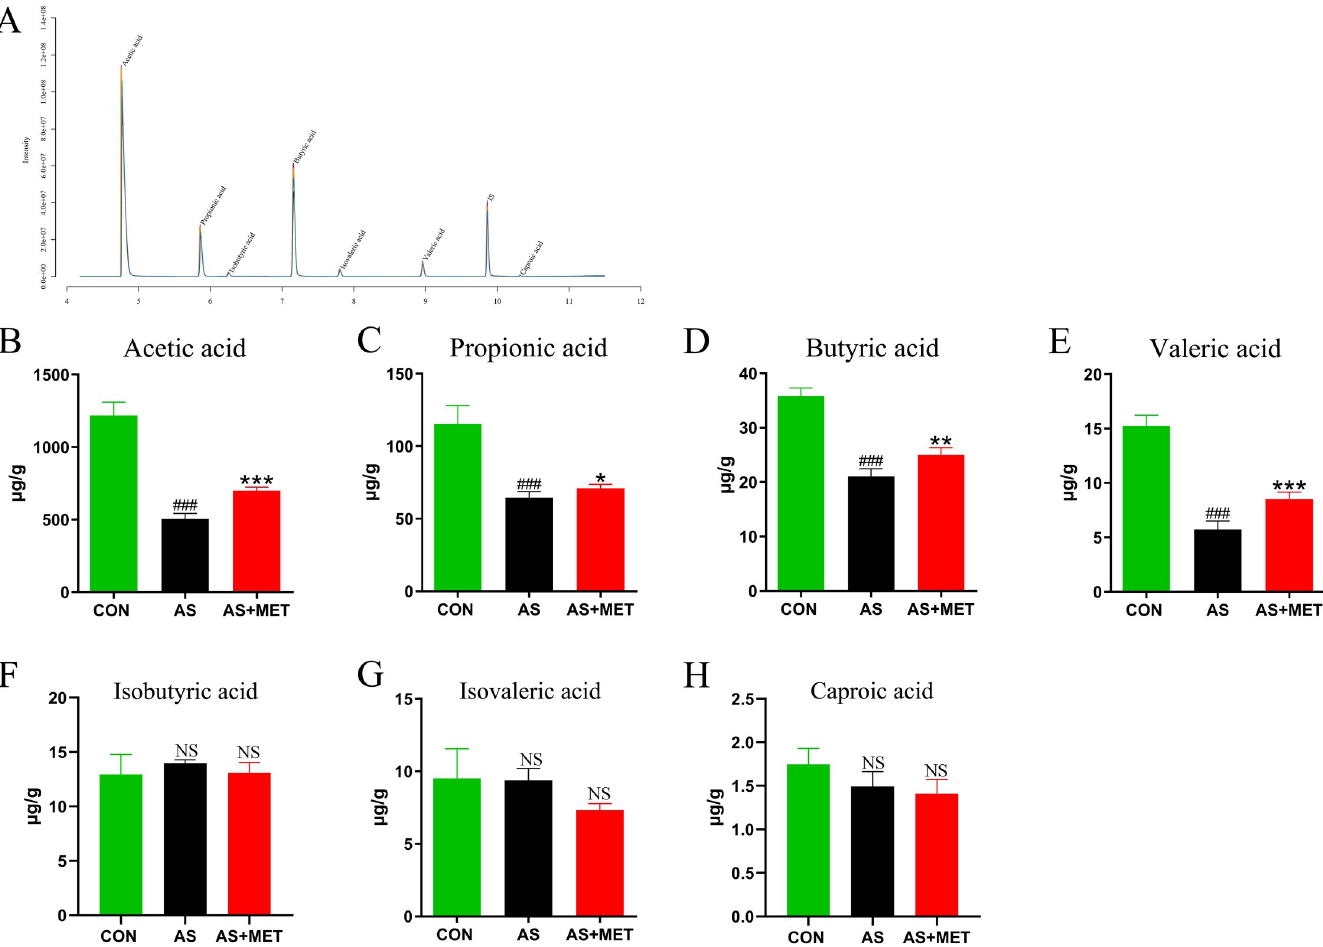
Fig 6. Measurement of the contents of SCFAs in different groups. Chromatogram of mice stool (A) . Determination of levels ( μ g/g) of Acetic acid ( B ); Propionic acid ( C ); Butyric acid ( D ); Valeric acid ( E ); Isobutyric acid ( F ); Isovaleric acid ( G ) and Caproic acid ( H ) by gas chromatography-mass spectrometer (GC-MS). # (CON vs. AS): # p < 0.05, ## p < 0.01, ### p < 0.001. � (AS vs. AS+MET): � p < 0.05, �� p < 0.01, ��� p < 0.001. NS, no significant difference.